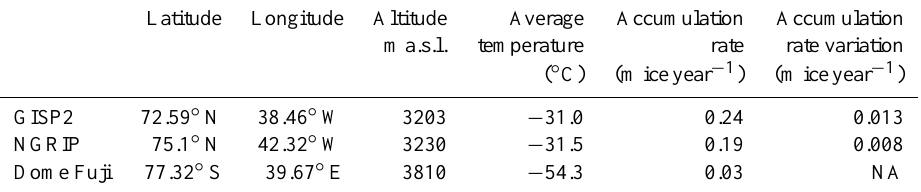
Table 1. Environmental parameters for GISP2, NGRIP and Dome Fuji. Temperatures for GISP2 and NGRIP are averages over the past 2100 years (Kobashi et al., 2015). Accumulation rates (Alley et al., 1997; Cuffey and Clow, 1997; Gkinis et al., 2014) for GISP2 and NGRIP are averages for the past 2100 years, and accumulation rate variations are calculated as standard deviations of accumulation rates in 21-year RMs. Annual average temperature and accumulation rate for Dome Fuji are from Watanabe et al. (2003). Latitude Longitude Altitude Average Accumulation Accumulation ma.s.l. temperature rate rate variation ( ◦ C) (miceyear − 1 ) (miceyear − 1 ) GISP2 72.59 ◦ N 38.46 ◦ W 3203 − 31.0 0.24 0.013 NGRIP 75.1 ◦ N 42.32 ◦ W 3230 Dome